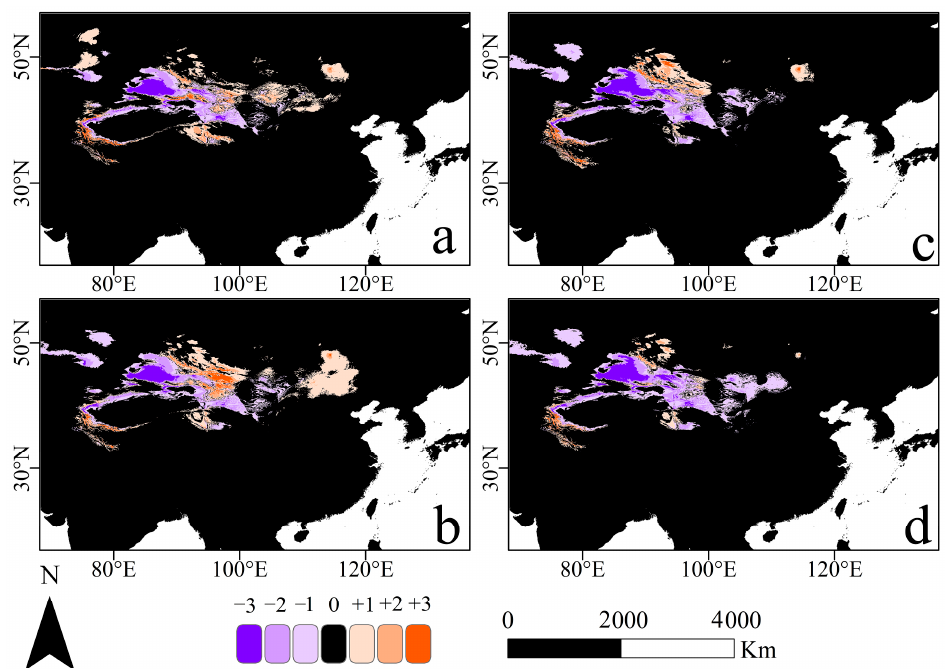
Figure 4. The increase and decrease maps of suitable habitats area: ( a , b ) RCP2.6 scenario; ( c , d